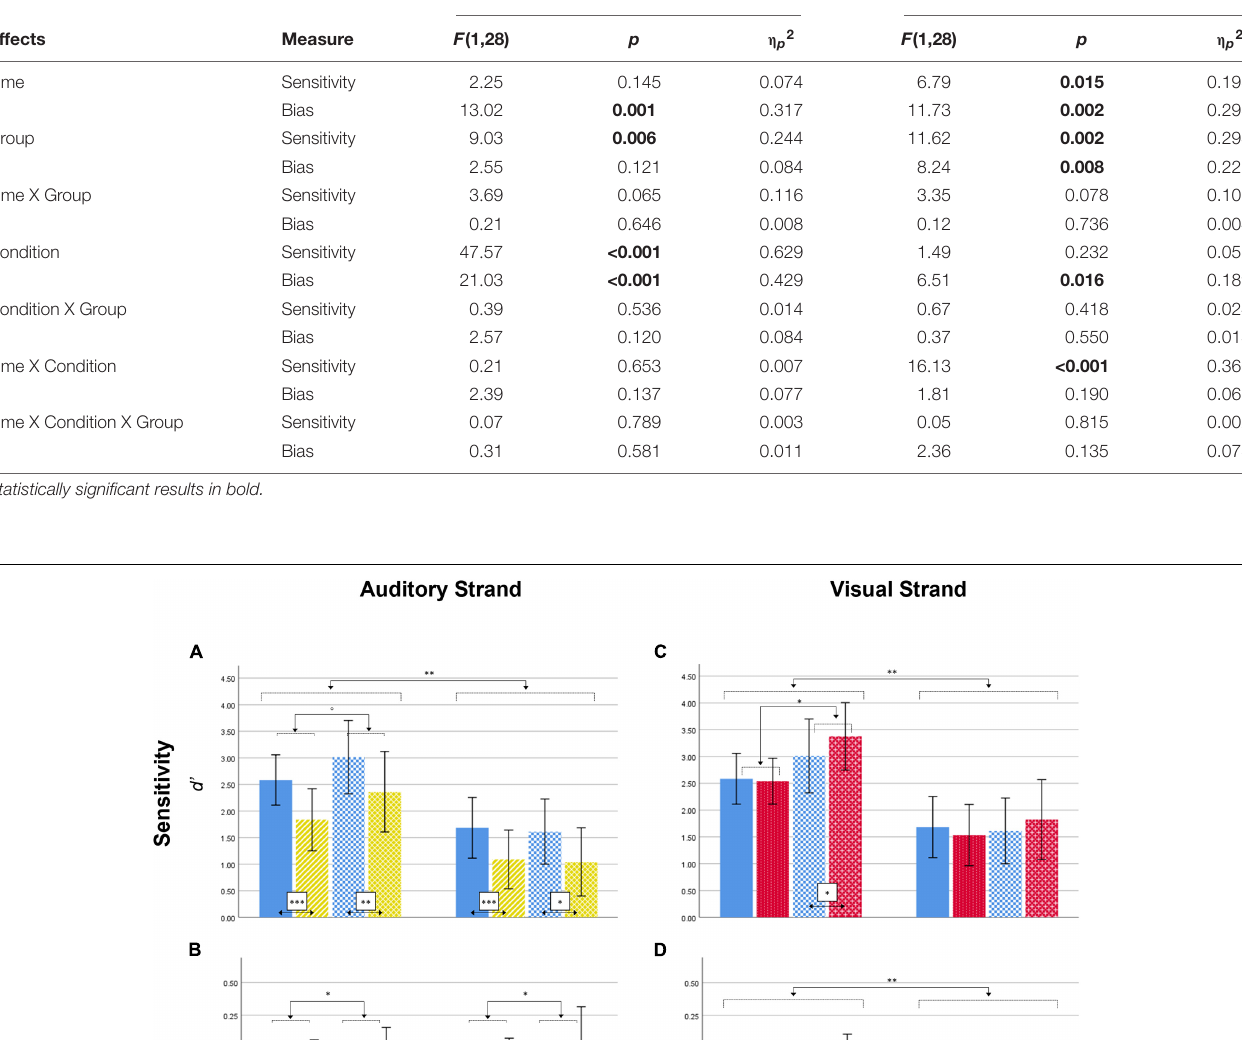
TABLE 1 | Summary of behavioral results, for the auditory and visual strands of analysis, for both measures (Sensitivity or d’, Bias or c). Auditory strand Visual strand